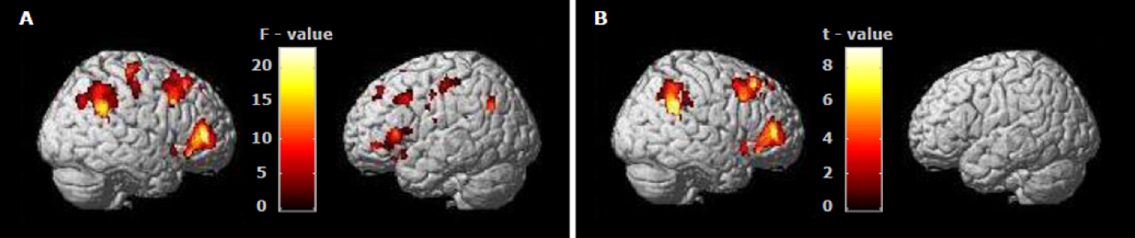
Figure 4. Differences in activation between the four finger observation conditions (A) and linear trend contrast (Index . Mid- dle . Ring . Little) (B). Differences in activation between the four observation conditions appeared bilaterally in mirror areas (A) while the activation maps of the linear trend contrast show the presence of higher activity in the MNS of the right hemisphere (B). Threshold: p=0.05 (A), p=0.01 (B), FDR; k=20.